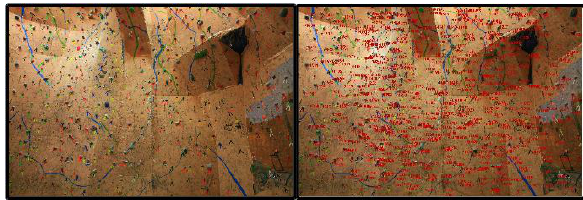
Figure 3: Image of Rock wall at Phoenix Rock Gym before and after feature detection (features marked with red)